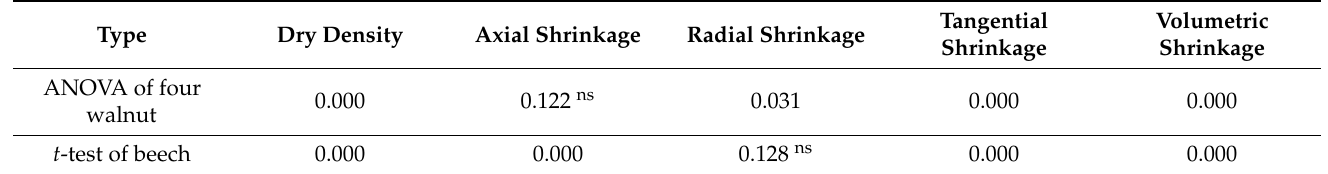
Table 4. Statistical analysis of physical